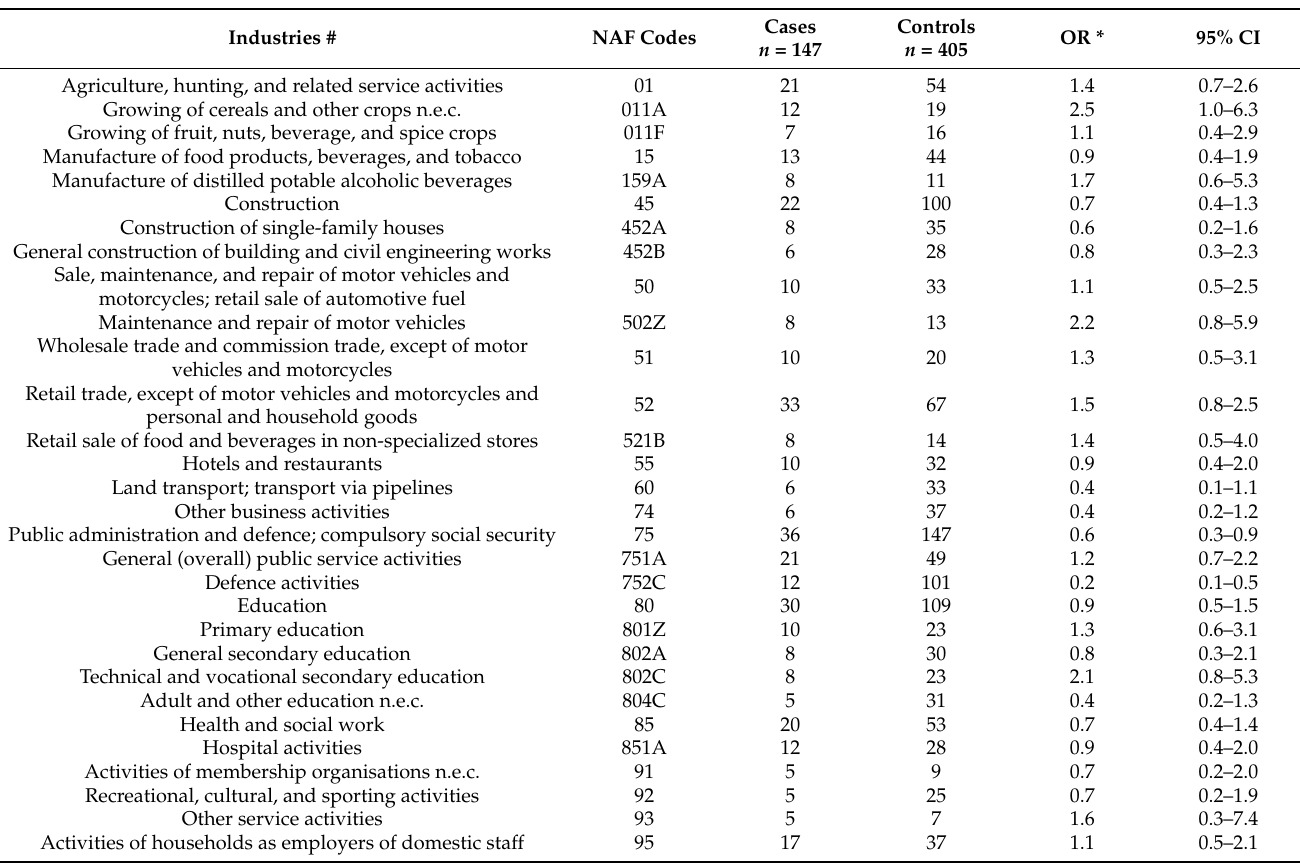
Table 2. Association between selected industries and lung cancer risk in the French West